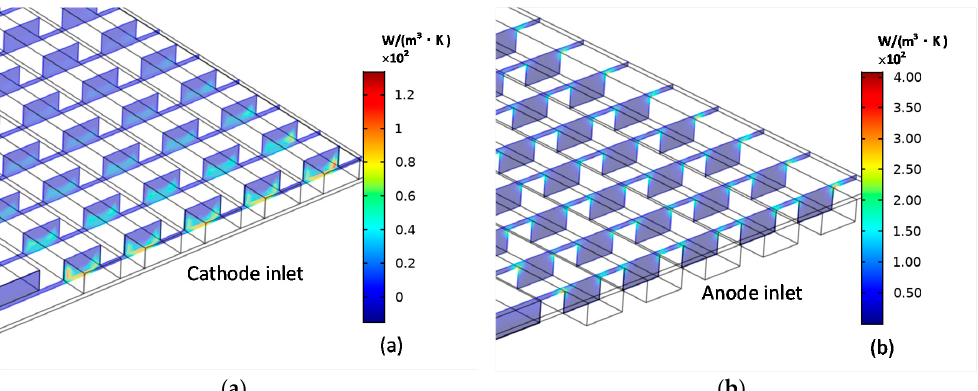
Figure 8. Cathode ( a ) entropy production and anode ( b ) entropy production caused by heat transfer. The distributions of the entropy production caused by the coupling of heat and mass transfer are shown in Figure 9. The largest entropy generation appears along the inlet channel profiles because of the presence of temperature gradients and species concentration gradients.